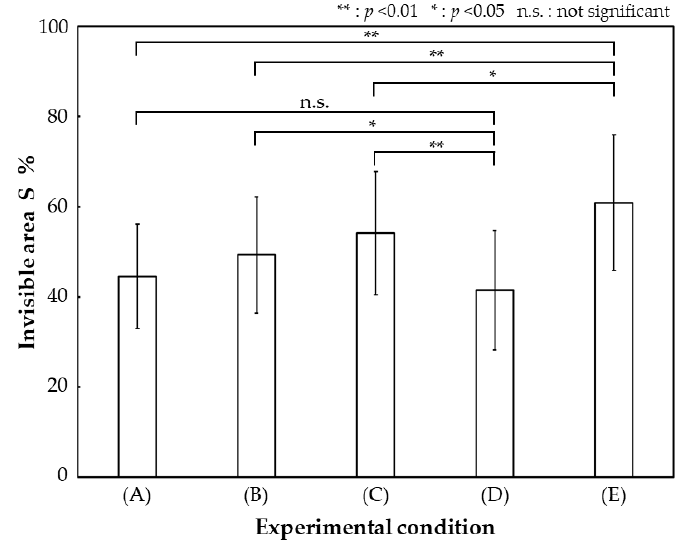
Figure 8. Invisible area rate.